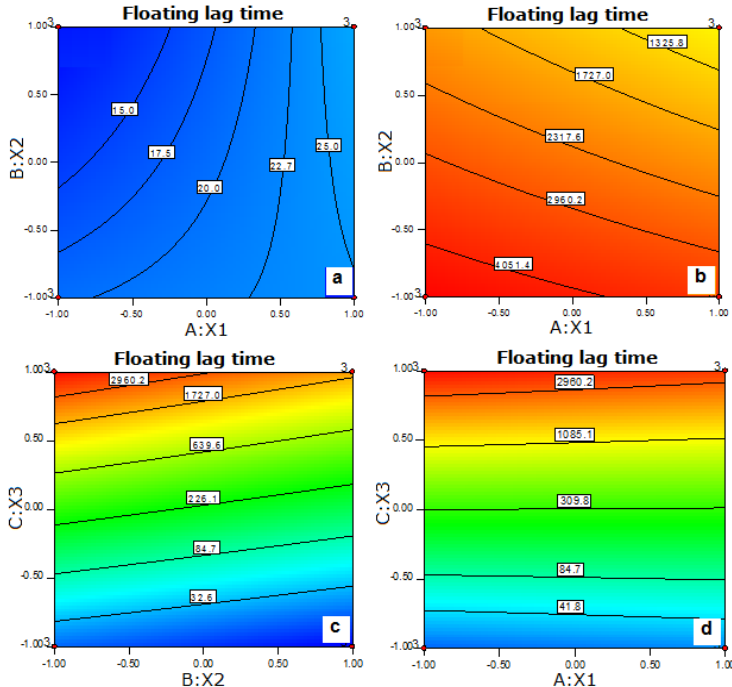
Figure 2. Contour plot of FLT a) X 3 at low level, b) X 3 at high level, c) X 1 at low level and d) X 2 at low level.